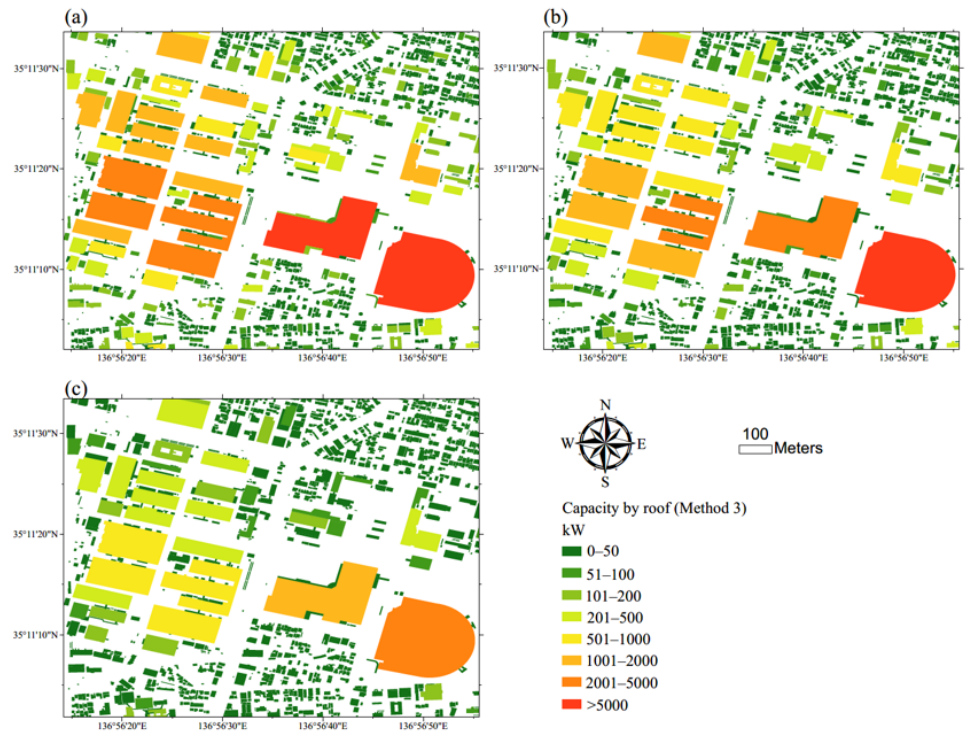
Figure 5. Introduction potential of each roof under three scenarios in a part of western Aichi using Solargis data (Method 3): ( a ) Scenario A, ( b ) Scenario B, and ( c ) Scenario C. Table 5. Total electricity generation potential of solar PV in western Aichi estimated by three methods under each